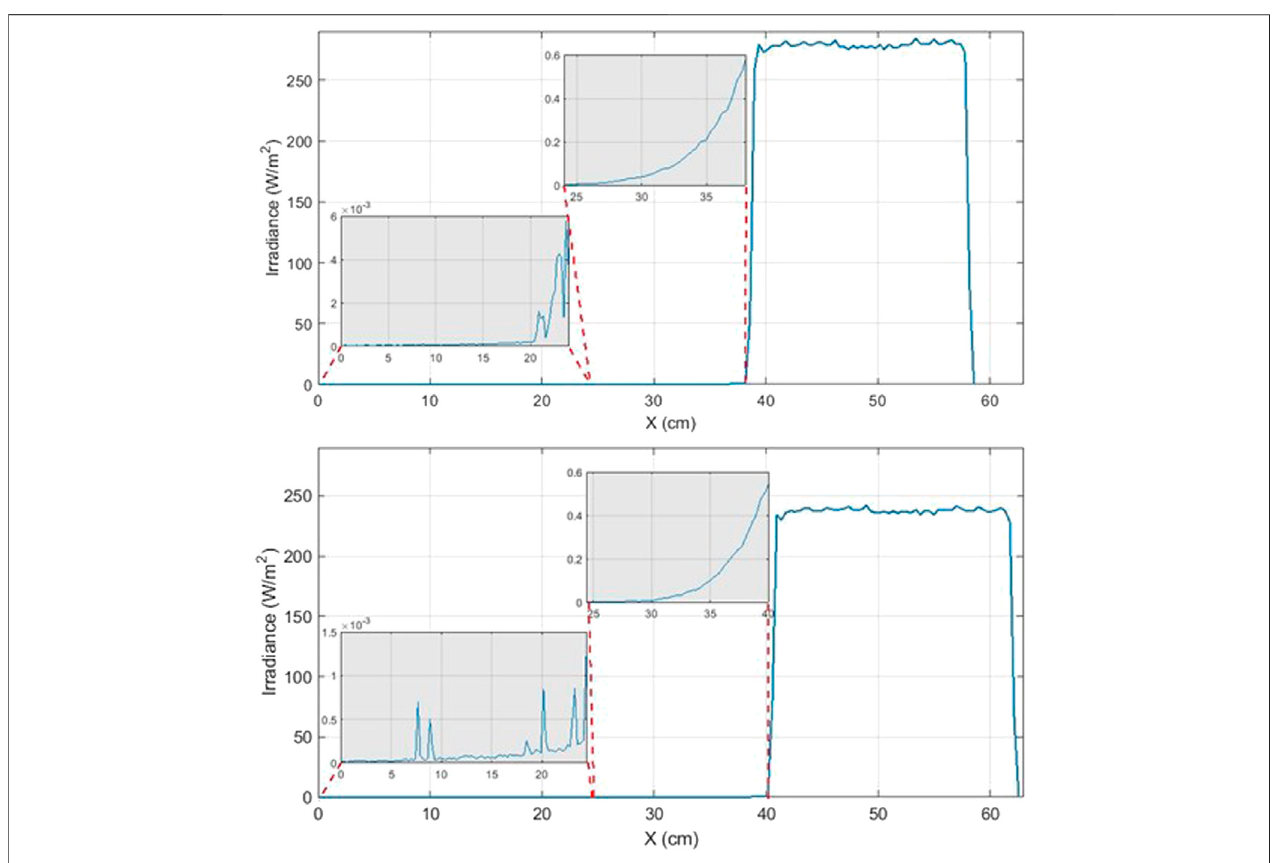
FIGURE 6 | Incoherent irradiance along the cavity of cross-sectional detector for geometries: cylinder/cone geometry (top) and cylinder/cone with a tube at the apex (bottom) . X (cid:1) 24, 4 cm marks the junction of the cone and cylinder.